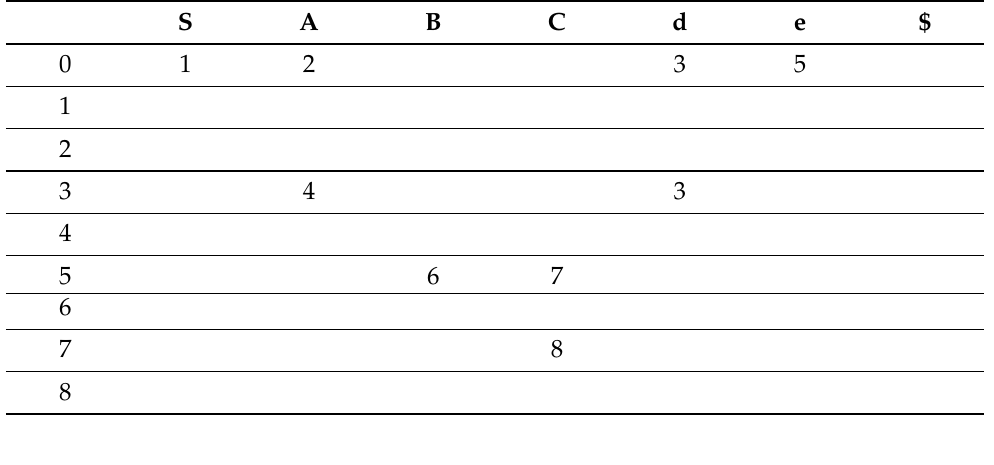
Table 7. The goto table T G for the specification Ξ in (5).